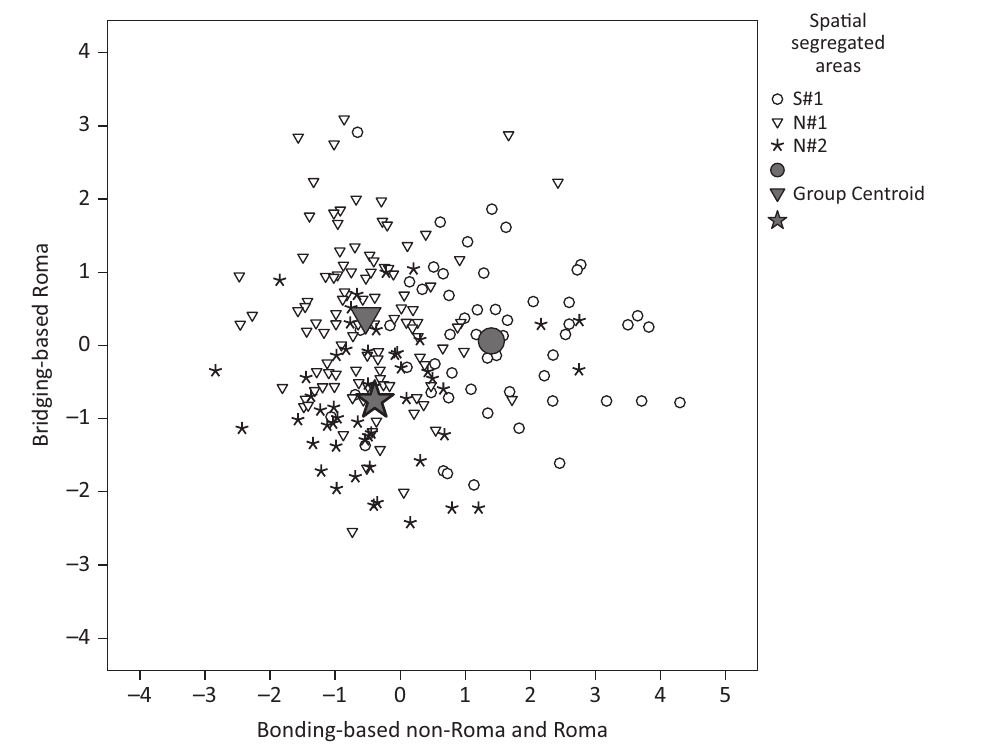
Figure 2. Plot of discriminant